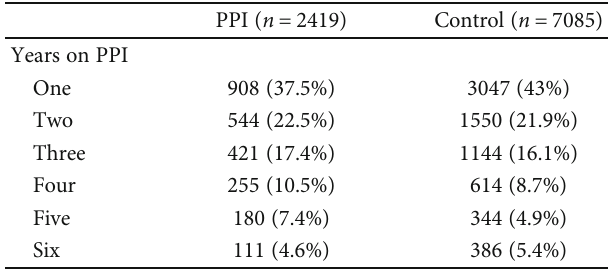
Figure 1: Flowsheet demonstrating the eligibility, inclusion, and exclusion criteria for patients in the study. Table 1: Baseline characteristics of the study participants. Table 2: Length (in years) of patients on PPI therapy and their matched controls. The control group was matched to those on PPI treatment with similar HbA1c data points. The percentages shown in the table demonstrate a similar distribution between both